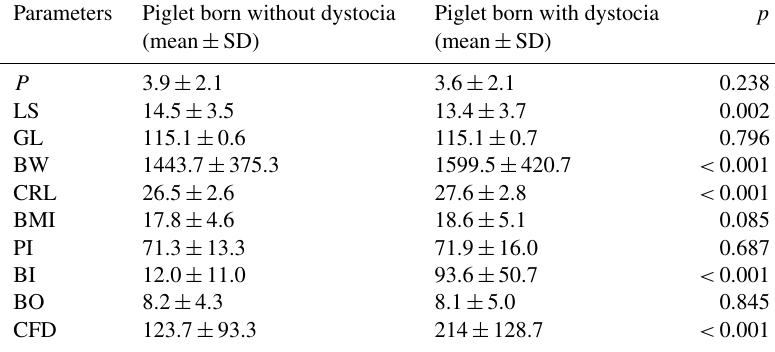
Table 1. Comparing some parameters between piglets born with ( n = 99) and without ( n = 799) a dystocia event.